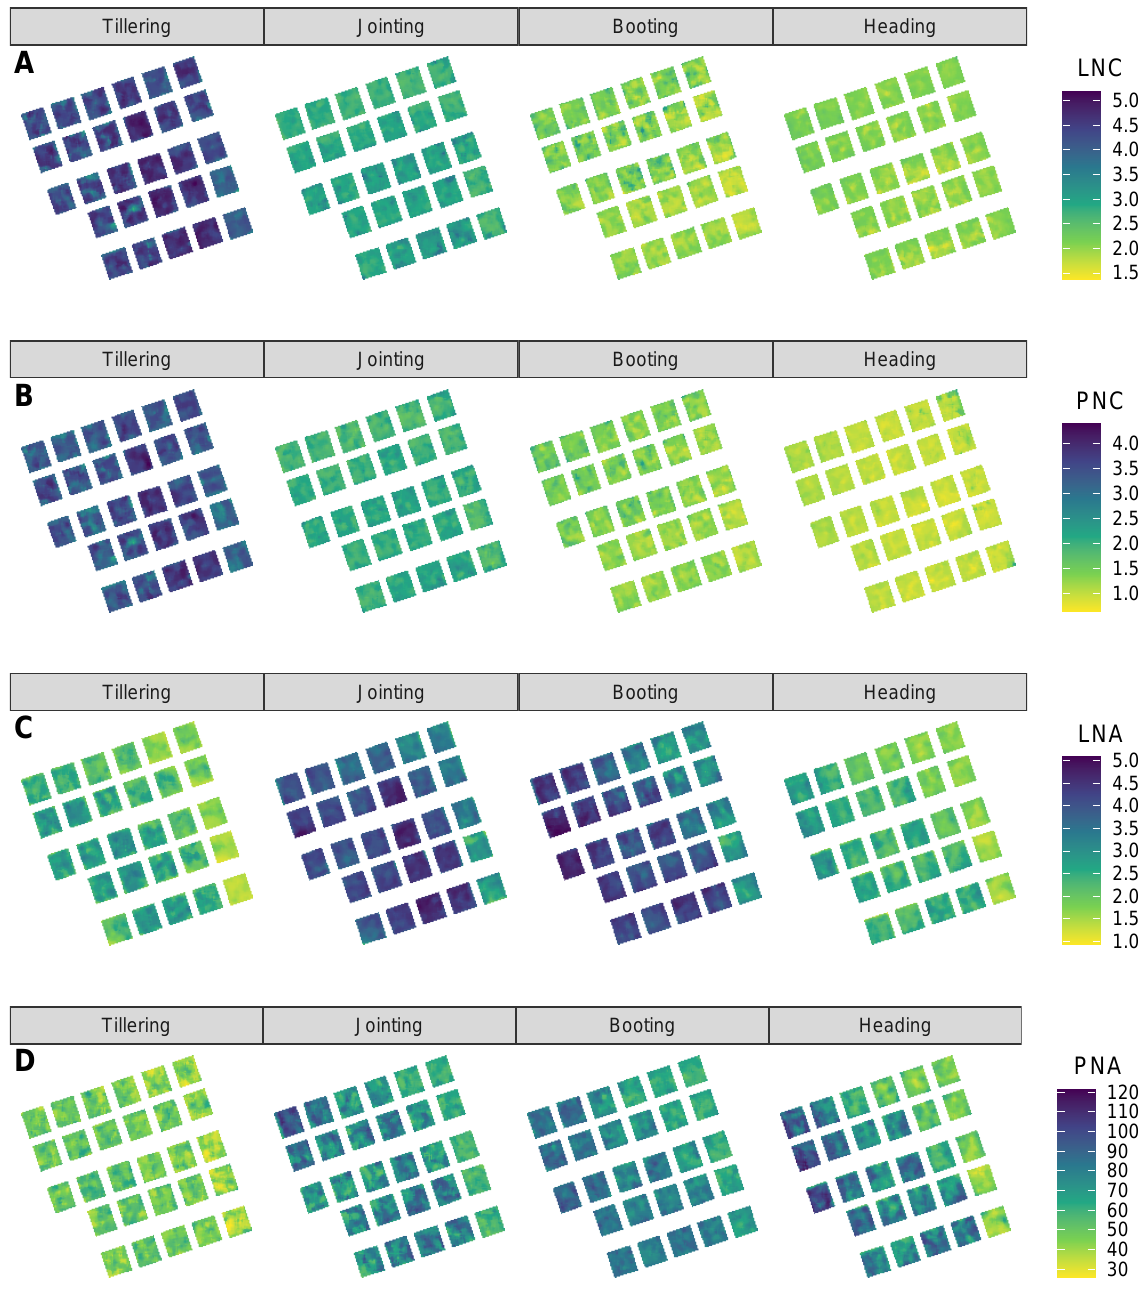
Figure 8. Spatial mapping results for LNC (%, A ), PNC (%, B ), LNA (g m − 1 , C ) and PNA (kg ha − 1 , D ), using the corresponding optimal full-growth-stage ML models (the ANN for LNC and PNC, and the SVM for LNA and PNA, as listed in Table